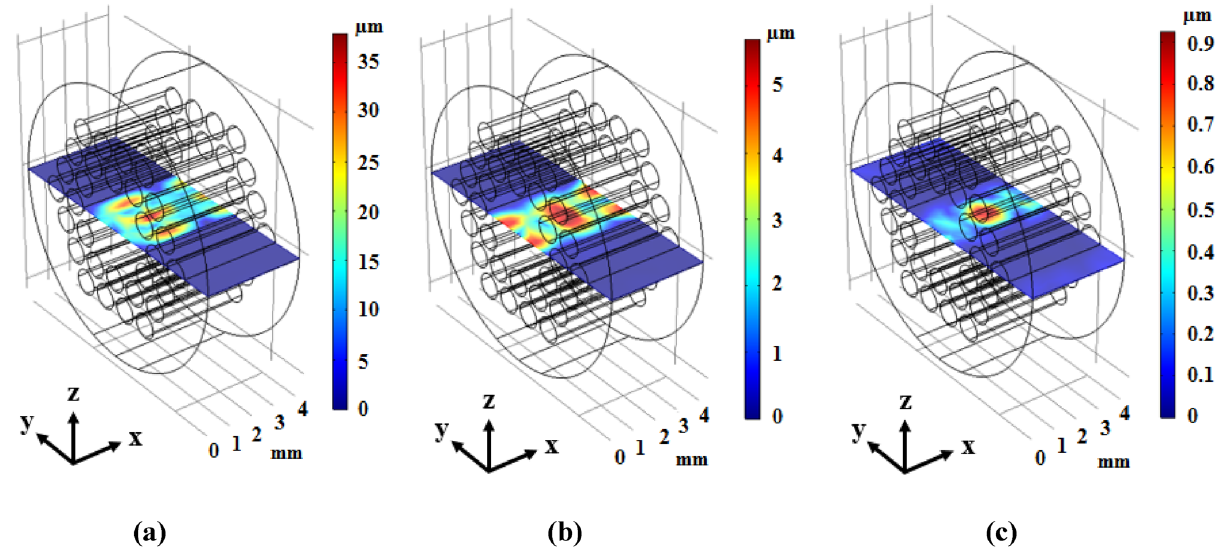
Figure 5. Displacement field of the phononic crystal fiber with large core corresponding to incident waves with ( a ) x-component and frequency of 524 kHz, ( b ) y-component and frequency of 424.5 kHz, and ( c ) z-component and frequency of 426 kHz in the